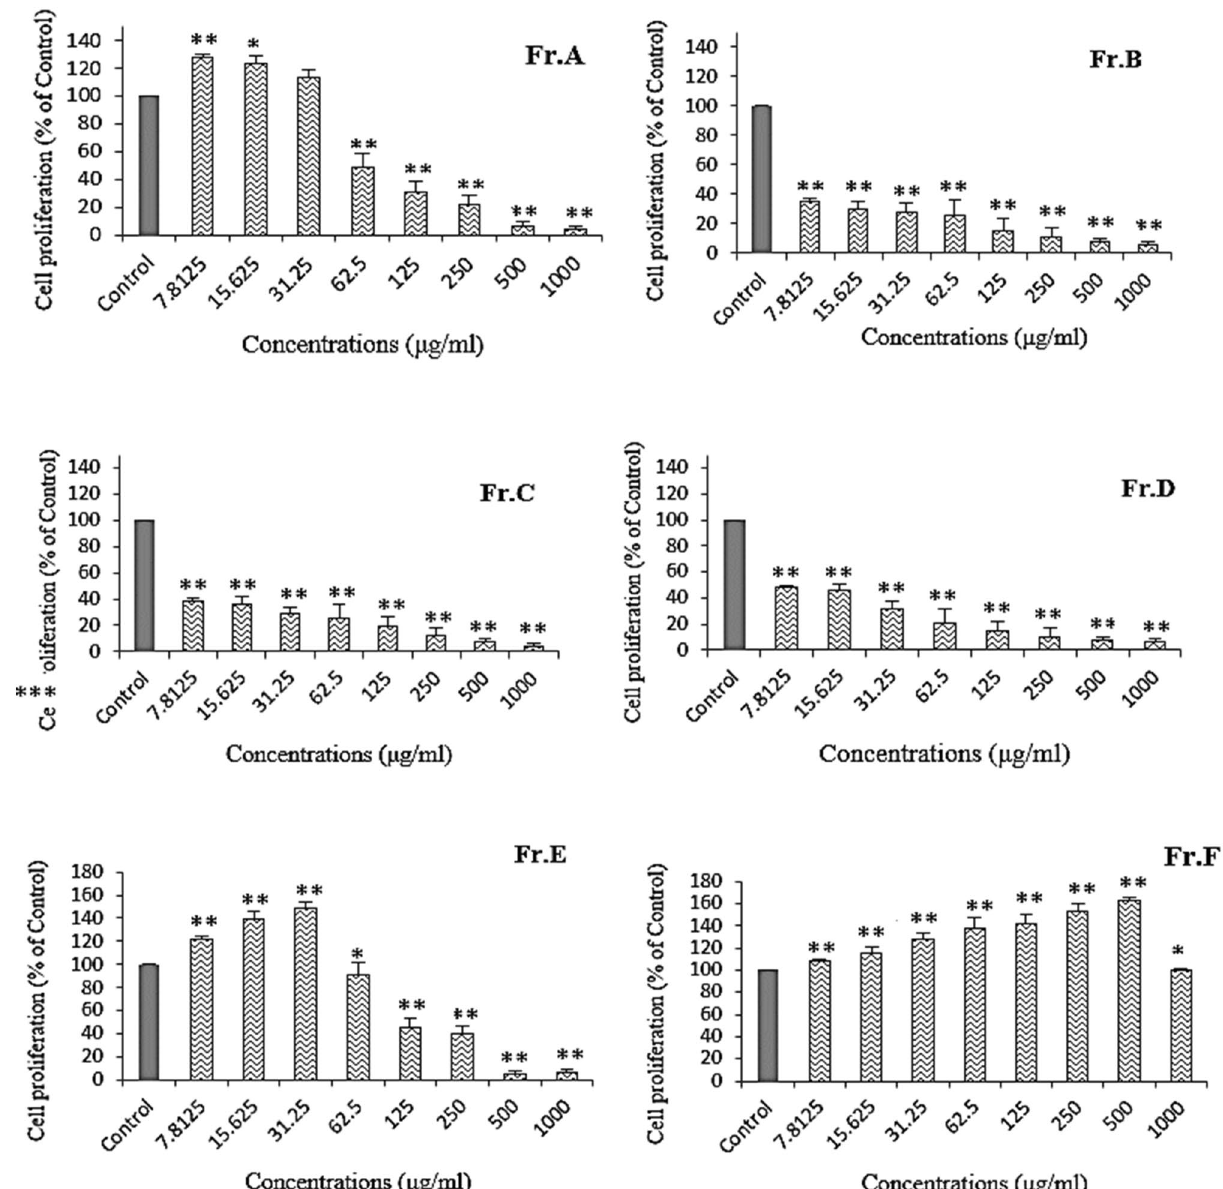
Figure 2. Effect of Fr. A to Fr. F obtained from the cyclohexane extract on the proliferation rate of Hs.27 fibroblast cells. All bars and values represent the mean ± SD of the three replicate experiments. *Significant difference (P < 0.05) and **P < 0.01 when compared to the control